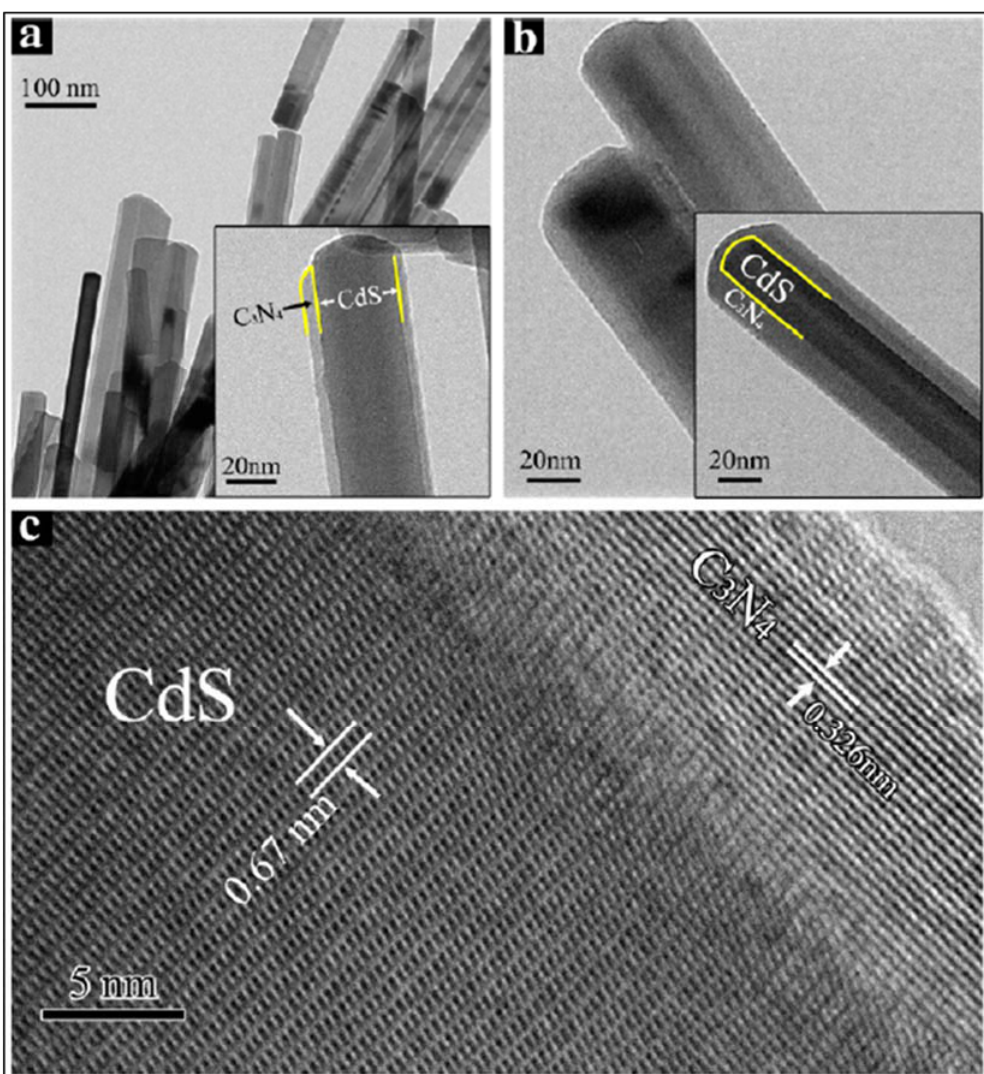
Figure 13. TEM images of the CdS/g-C 3 N 4 nanowires with 2 ( a ) and 4 ( b ) wt.% of g-C 3 N 4 . The HRTEM image of CdS/g-C 3 N 4 with 4 wt% g-C 3 N 4 is presented in ( c ). Reproduced with permission from reference [128].